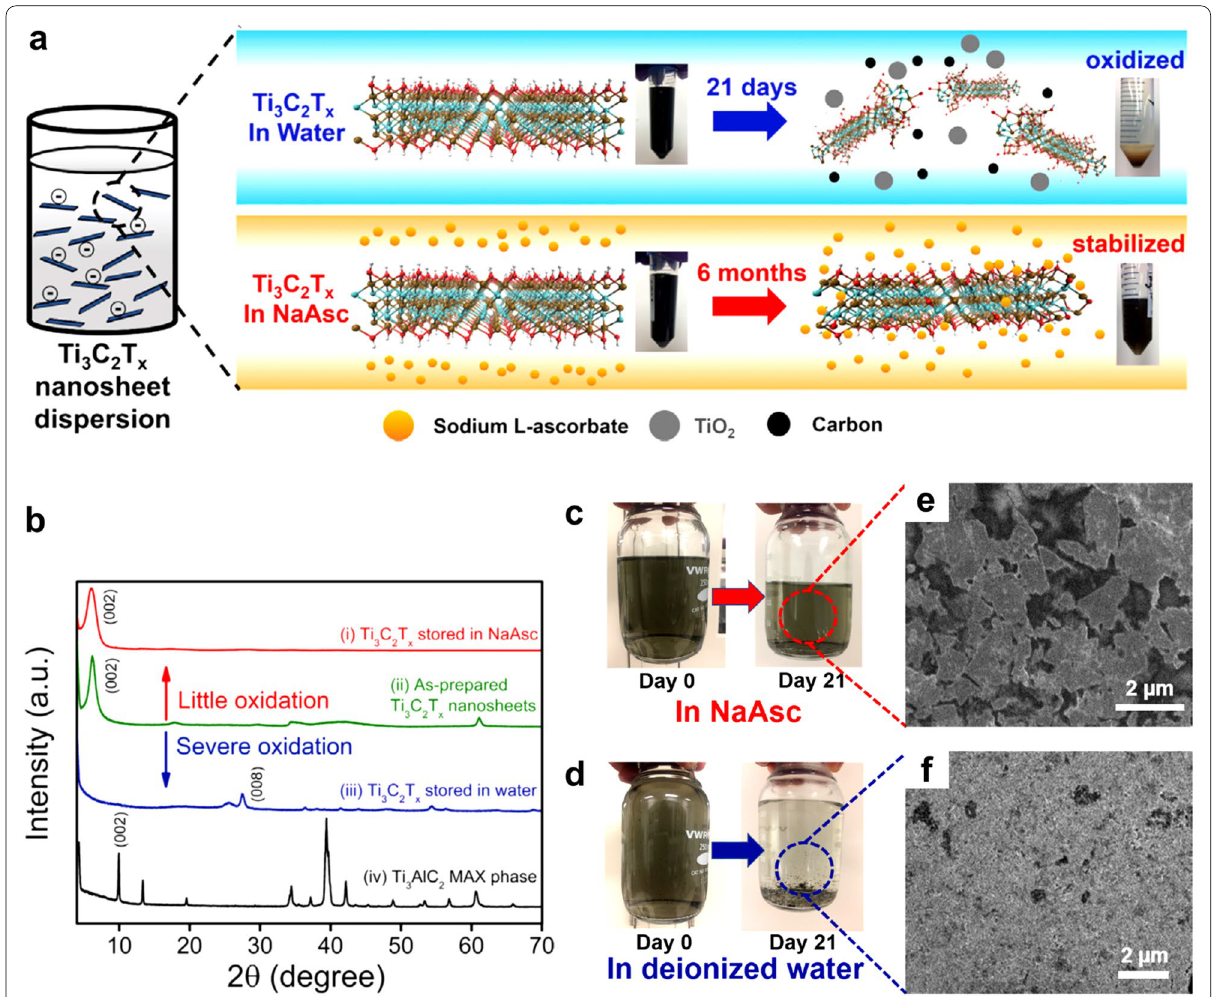
Fig. 8 a Schematics of shelf-stable Ti 3 C 2 T x nanosheet dispersion enabled by antioxidant sodium l -Ascorbate. b XRD patterns of Ti 3 AlC 2 MAX phase, Ti 3 C 2 T x stored in water for 21 days, as-prepared fresh Ti 3 C 2 T x , and Ti 3 C 2 T x stored in NaAsc for 21 days. Digital photographs of the Ti 3 C 2 T x suspensions on days 0 and 21 in c NaAsc and d deionized water. SEM images of Ti 3 C 2 T x suspensions stored for 21 days in e NaAsc and f deionized water. a – f Reproduced with permissions from ref. [61]. Copyright (2019),